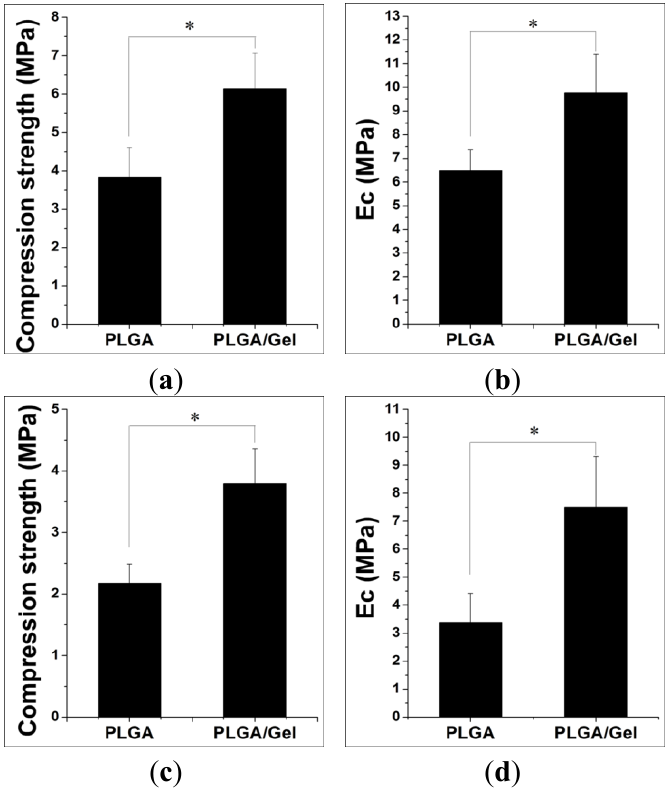
Figure 5. Compressive strength and Ec of PLGA and PLGA/Gel scaffolds under dry ( a , b ) or wet states ( c , d ). The data were represented as mean ± standard deviation (SD; n = 3; * p < 0.05).